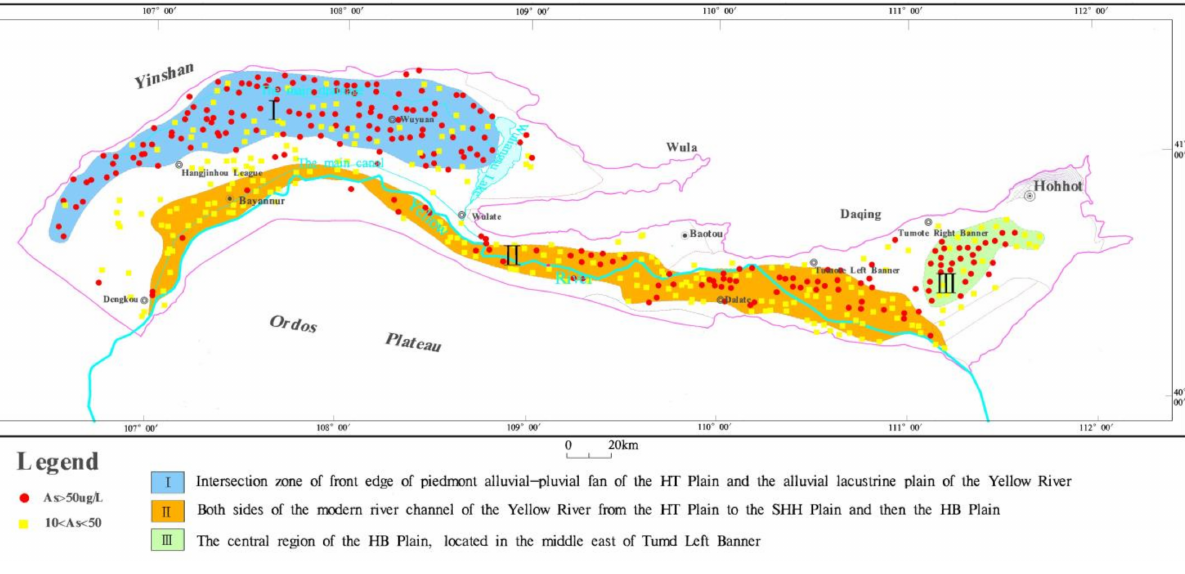
Figure 3. Contour map of high-arsenic shallow groundwater points and groundwater level elevation in Hetao